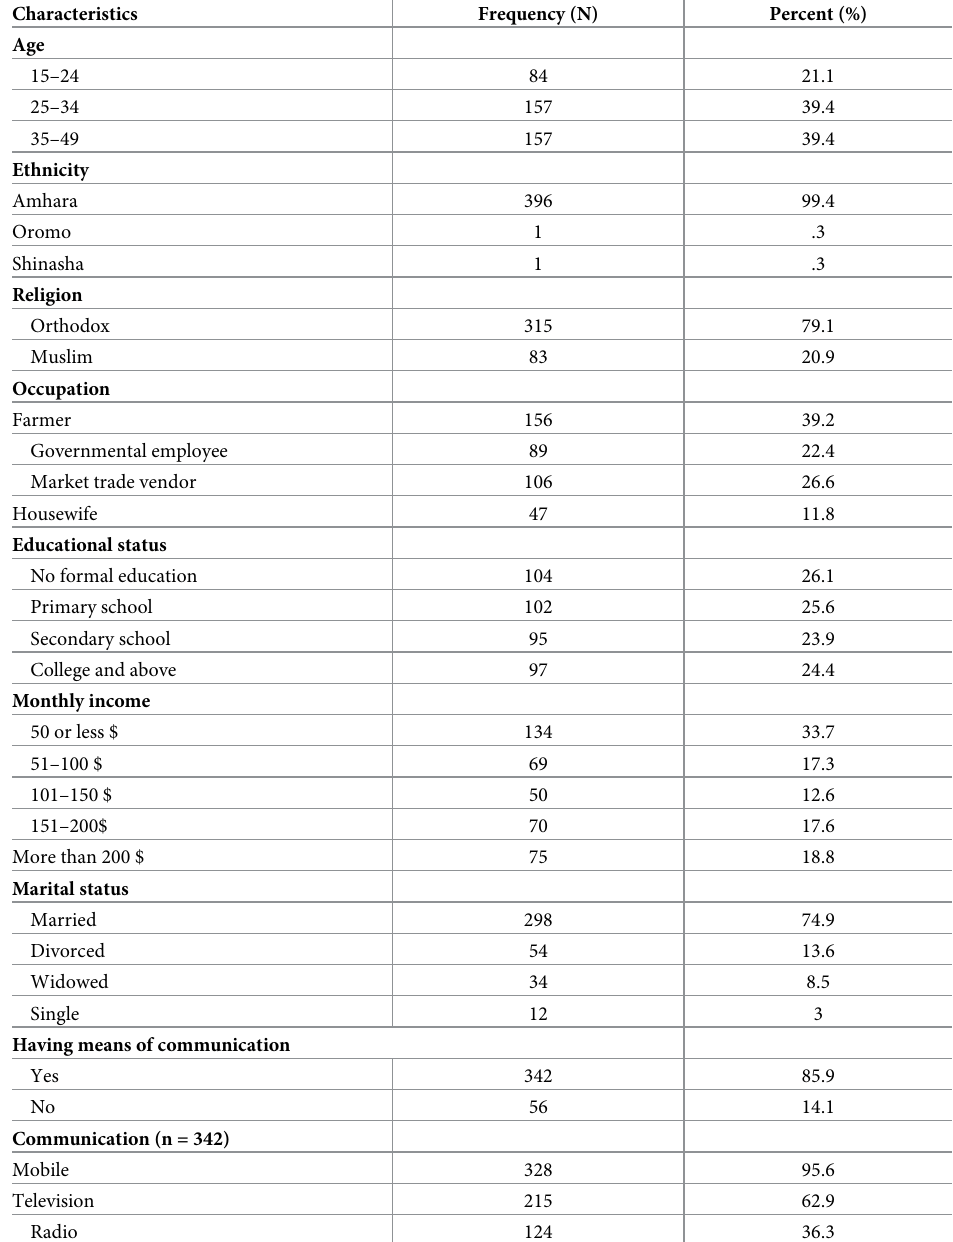
Table 1. Socio-demographic characteristic of pregnant women in Addis Zemen primary hospital, Northwestern Ethiopia, 2018 (n = 398).